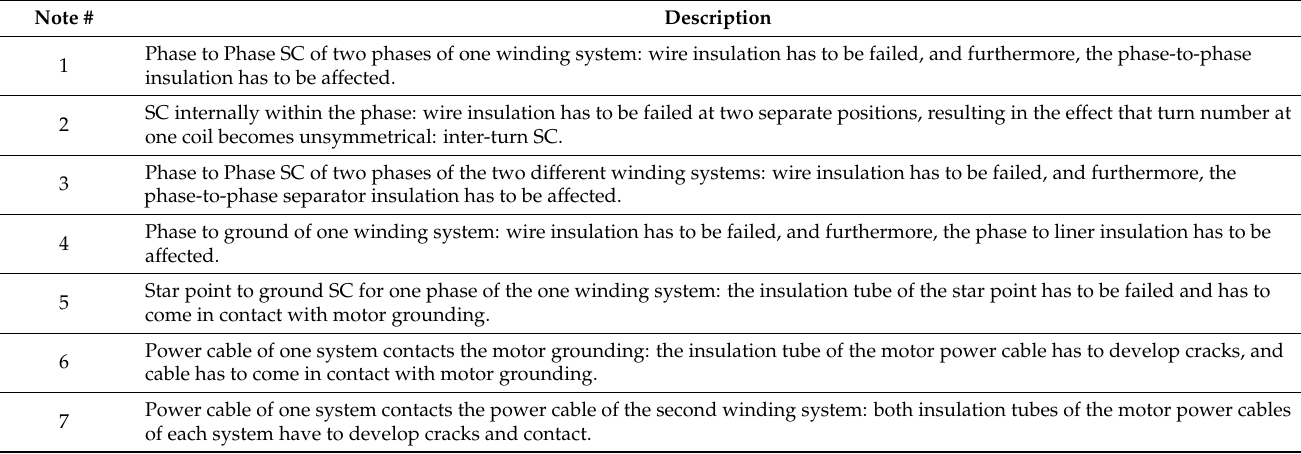
Table 4. Notations for Figure